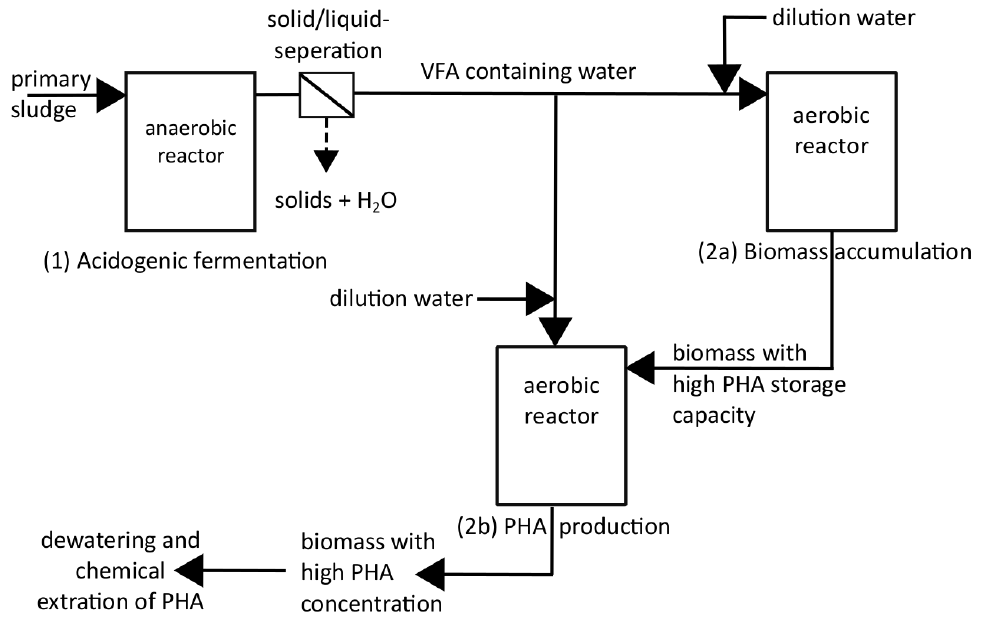
Figure 2. PHA production scheme.